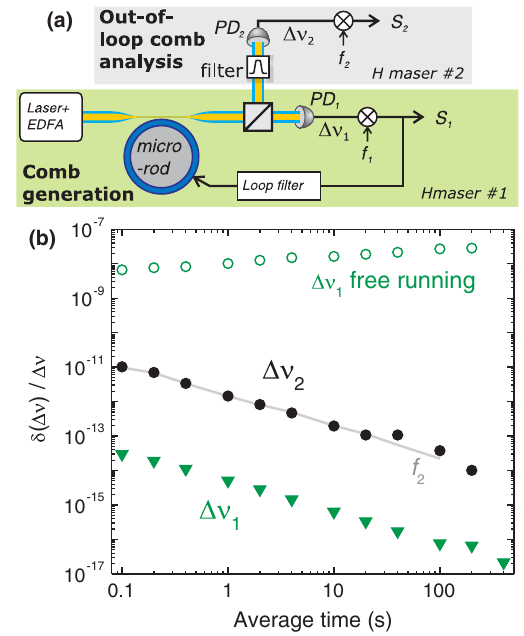
FIG. 3. Microcomb line-spacing stability. (a) Schematic of our systems for microcomb generation and line-spacing stabilization (green box), and ‘‘out-of-loop’’ analysis (gray box). The entire optical path is in fiber, including a programmable optical filter used to study the line-spacing stability for portions of the comb (Fig. 4). Commercial frequency synthesizers create references f that are used for baseband conversion, and signals S are 1 ; 2 1 ; 2 measured. The generation and analysis systems have indepen- dent maser references. (b) Line-spacing Allan deviation versus averaging time for (triangles) stabilized residual, (points) stabi- lized absolute, and (open circles) free running. The gray line shows the Allan deviation of reference f 2